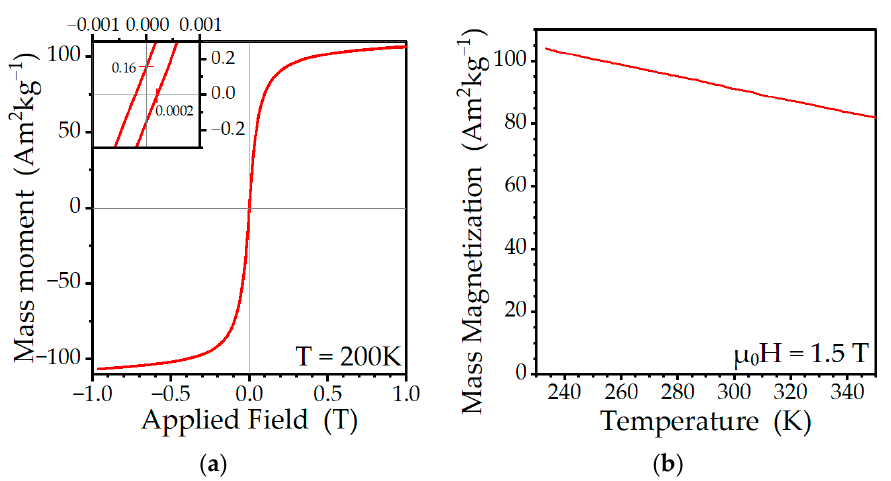
Figure 6. Magnetization study of MnZn ferrite nanoparticles grown in silicone. ( a ) The hysteresis loop measured at 200 K. ( b ) The temperature dependence of the mass magnetization measured in a 1.5 T field.